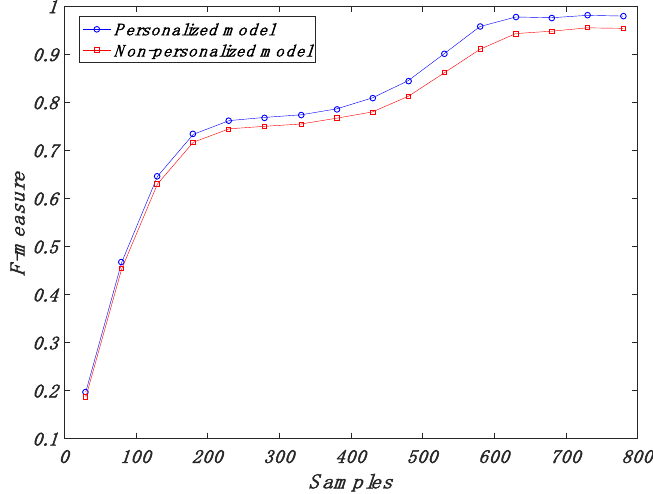
Figure 3. Comparison between personalized models and non-personalized models for different training dataset sizes.